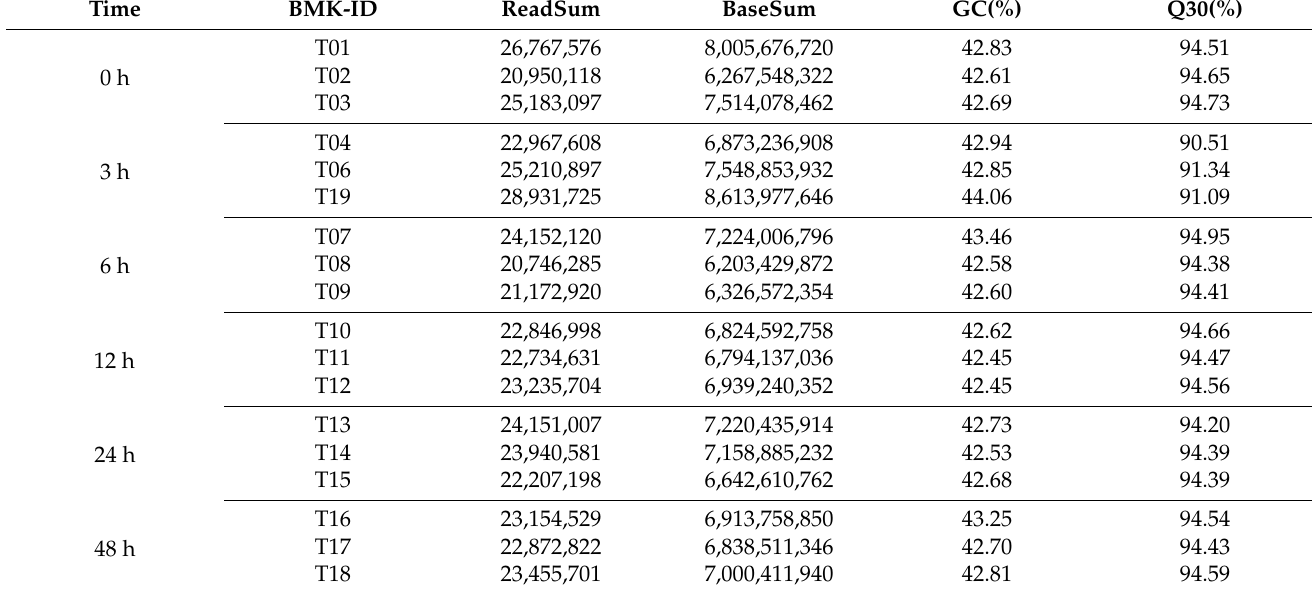
Table 1. Statistics of NGS of each sample.